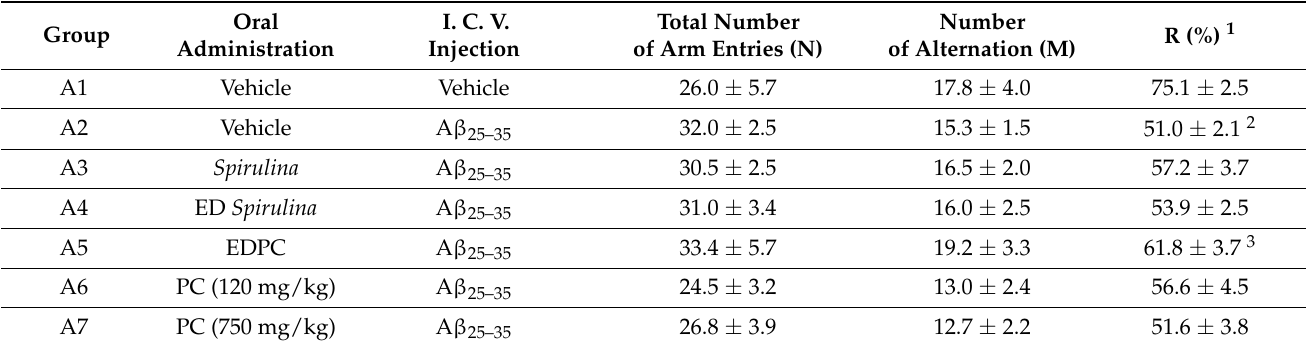
Table 1. Spontaneous alternation ratio (R) measured in a Y maze.